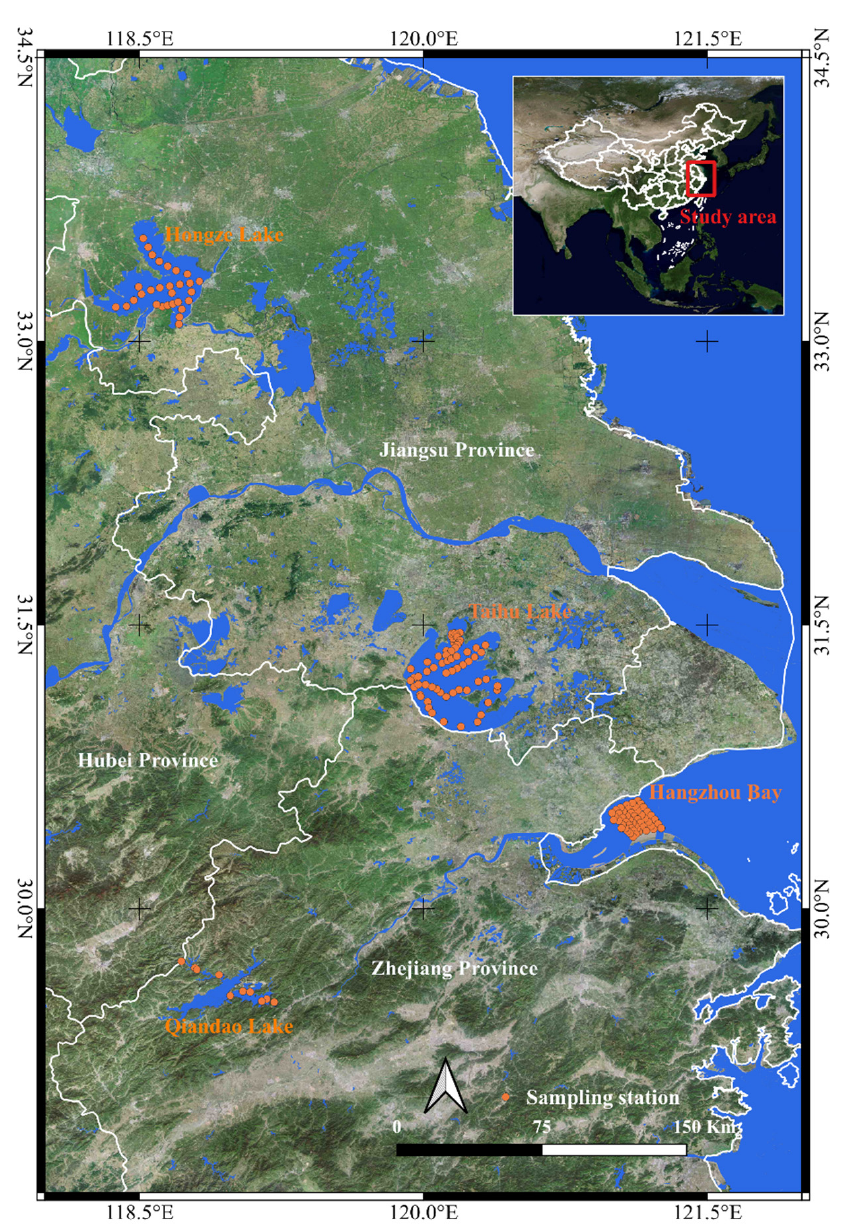
Figure 1. Spatial distribution of sampling stations.